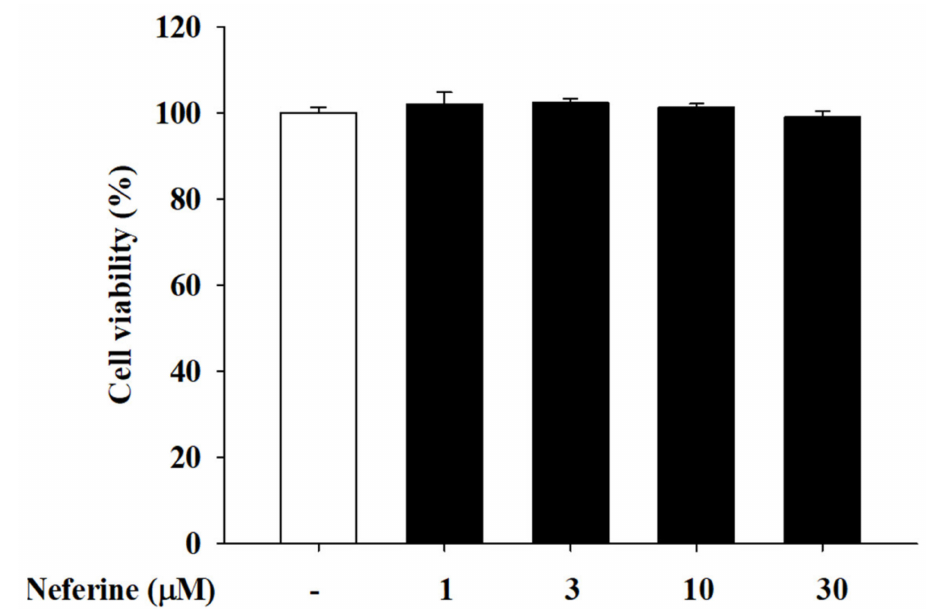
Figure 1. Cell viability of HaCaT cells after pretreatment with different concentrations of neferine (1, 3, 10, and 30 µ M). HaCaT cells were treated with different concentrations of neferine at 37 ◦ C for 24 h in 5% CO 2 . Values represent the mean ± SEM from at least three